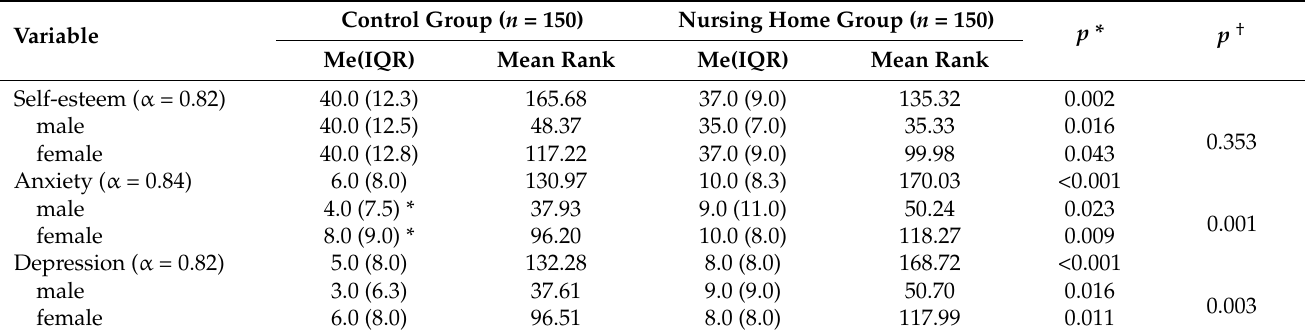
Table 2. Measures of self-esteem, anxiety, and depression in older people.